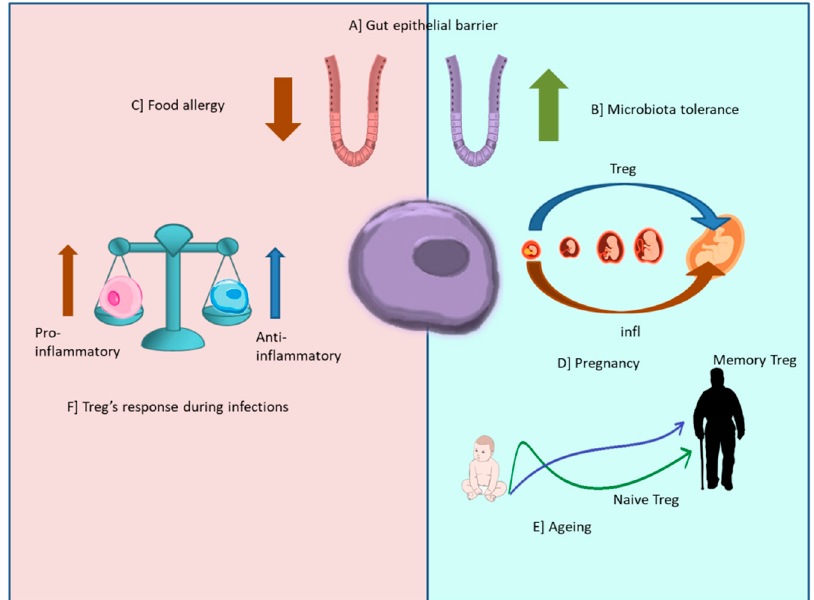
Figure 3. The mechanism of action of Treg during different physiological and pathological states [ A ]. The figure shows the role of Treg cells in the intestinal epithelial barrier, the green arrow indicates the increase in Treg cells, which allows for immunological tolerance to the microbiota [ B ], the brown arrow represents the deregulation of Treg cells that leads to immune disorders such as celiac disease, food allergy, or irritable bowel [ C ]. During pregnancy [ D ], the role of Treg is crucial for maternal–fetal tolerance and implantation, the purple arrow indicates that once fertilization occurs, a substantial increase in Treg cells is observed, creating a tolerogenic environment, whose composition changes throughout gestation; this increase decreases at the end and after each pregnancy. The red arrow indicates an inflammatory state at the beginning and at the end of gestation. During aging [ E ], the blue arrow indicates an increase in memory Treg cells and the green arrow indicates a decrease in naive Treg cells. During infections [ F ], the blue arrow indicates an increase in Treg cells that generates an anti-inflammatory state, while the predominance of Th17 cells, indicated by the red arrow, favors a pro-inflammatory state.